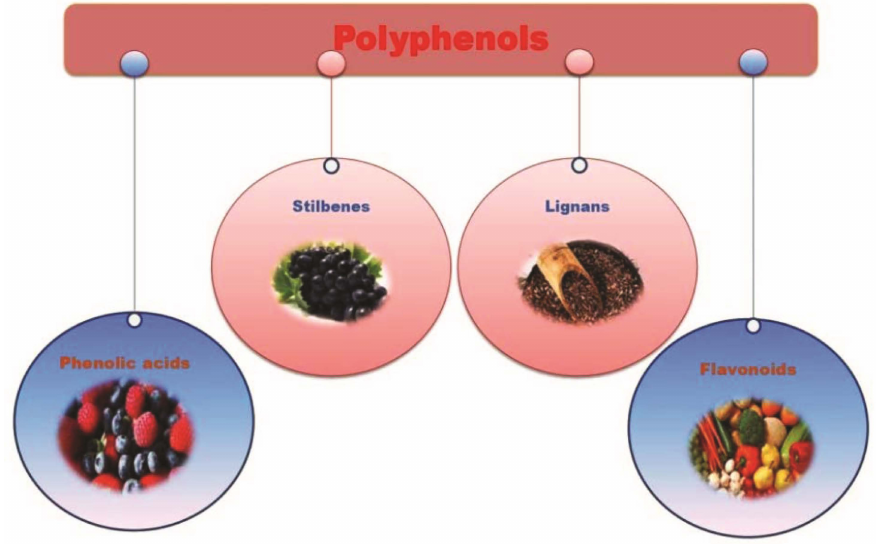
Figure 1. Polyphenol classification including phenolic acids, stilbenes, lignans and